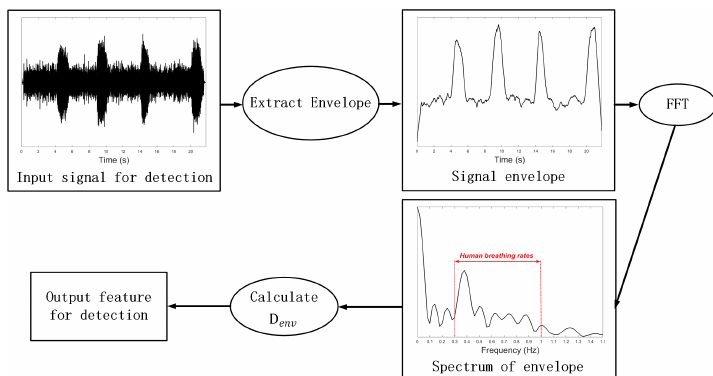
Figure 3. Flow chart of calculating D env from signals.